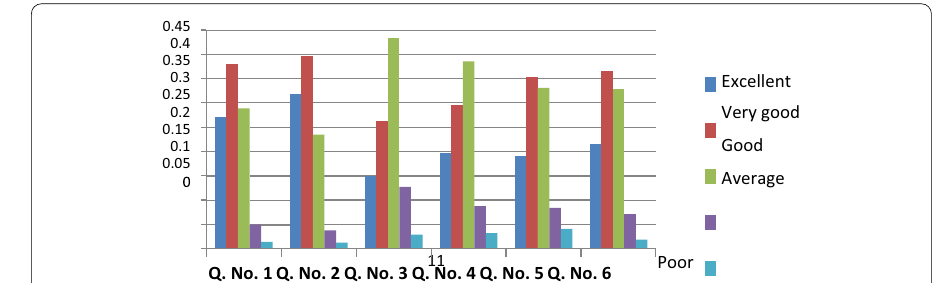
Fig. 1 Graphical representation of the responses obtained for the teacher’s effectiveness